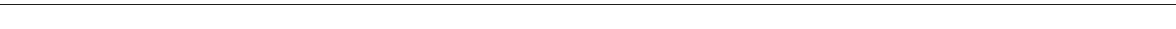
Fig. 3 Embryo-derived spleen CD11b lo F4/80 hi macrophages depend on CSF1R-mediated signals for their generation. a Photograph of E10.5 embryo with yolk sac (YS). Scale bar corresponds to 1 mm. b , c Dot plots show yolk sac ( b ) or body cells excluding head tissues ( c ) analyzed for the expression of CD45 and KIT (left). CD45-expressing cells are further resolved for the expression of CD11b and CSF1R (second left). CSF1R + cells co-express F4/80 (third left). Plots show the frequencies of F4/80-expressing cells within the CSF1R-positive population (second right). Each dot represents one mouse. CD45-negative cells are resolved for the expression of F4/80 and CSF1R (right). d Schematic outline of TAM-induced depletion of CSF1R expression in the embryo (top). Contour plots resolve CD45 + fetal liver cells from E14.5 R26-CreER T2 + ;Csf1r F/ − and control embryos for the expression of CD11b and F4/80 (bottom). e Plots show the frequencies of CD11b + F4/80 lo (left) or CD11b lo F4/80 hi (middle) cells in the fetal liver of R26-CreER T2 + ;Csf1r F/ − and control embryos. Right plot shows fold-change differences of leukocyte and macrophage populations in the fetal livers. Data are summarized from three independent experiments. Two-sided t test (left) and Mann – Whitney U test (right) were performed. SD is shown. f Schematic outline of TAM-induced depletion of CSF1R expression in R26-CreER T2 + ;Flt3 − / − ;Csf1r F/ − and control embryos. TAM was administered at E10.5. g Frequencies (left) and fold-change differences (right) of leukocytes and RP-Mps in the spleens of R26-CreER T2 + ;Flt3 − / − ;Csf1r F/ − and control pups at E19.5. Data are summarized from four independent experiments. Two-sided t test (left) and Mann – Whitney U test (right) were performed. SD is shown. h Dot plots show DCs in R26-CreER T2 + ;Flt3 − / − ; Csf1r F/ − and control mice at E19.5. Numbers indicate frequencies of dendritic cells within Dapi − cells. i , j Plots show DC frequencies and fold-change differences of leukocytes and DCs in the spleen of E19.5 pups ( i ) or at 3 weeks of age ( j ) in R26-CreER T2 + ;Flt3 − / − ;Csf1r F/ − and control mice that were TAM-induced at E10.5. Data are summarized from three independent experiments. Two-sided t tests (left) and Mann – Whitney U tests (right) were performed. SD are